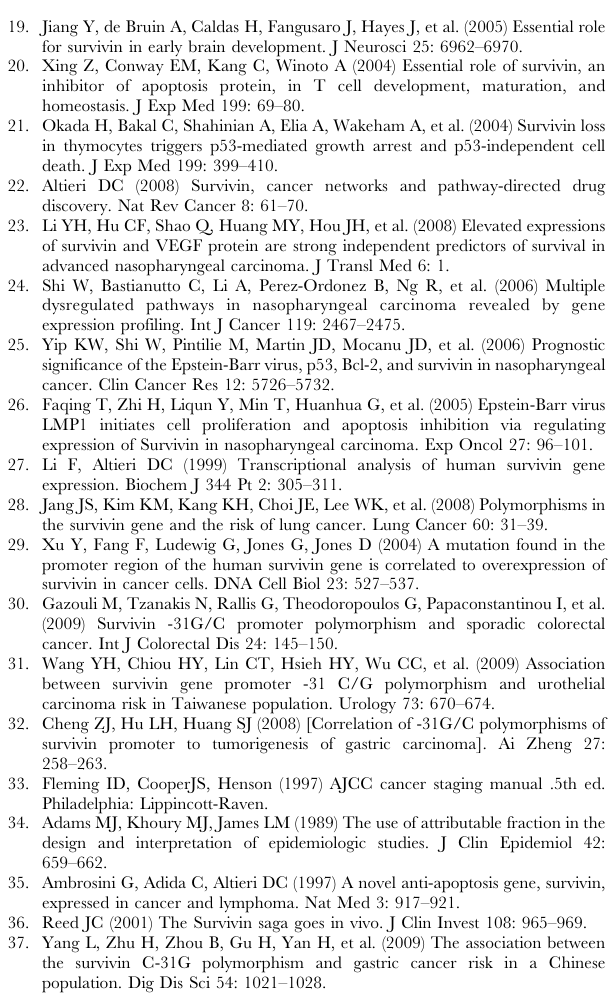
Table S2 The data of controls from Taiwan, Jiangsu and Hubei were derived from previously published studies [31,32,37]. ASW, African ancestry in southwest USA; YRI, Yoruba in